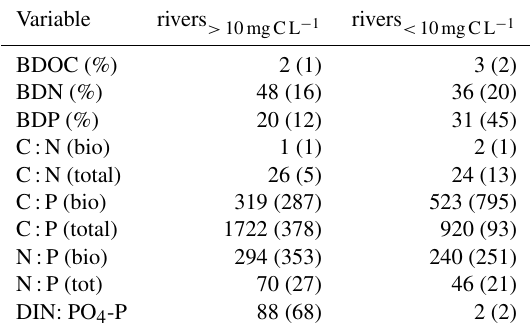
(de- > 10mgCL − 1 (depen- < 10mgCL − 1